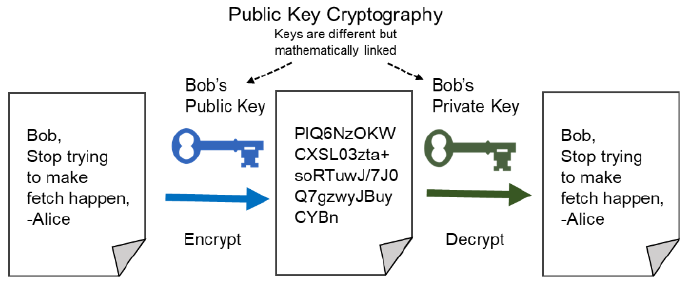
Figure 8. Asymmetric-key cryptography.